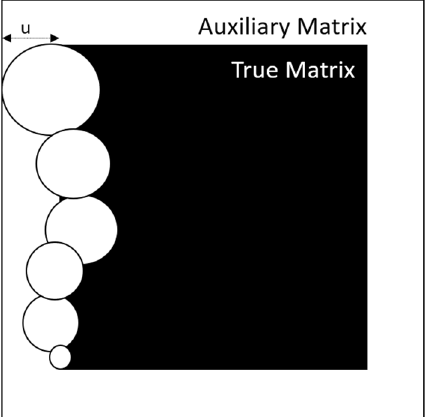
Figure 6. Identification process at the edge for the image cropping (TrueMatrix) from Auxiliary matrix. From each of the sides of the matrix, it is removed to obtain a TrueMatrix with the size of the desired matrix where u is the maximum diameter divided by 2.